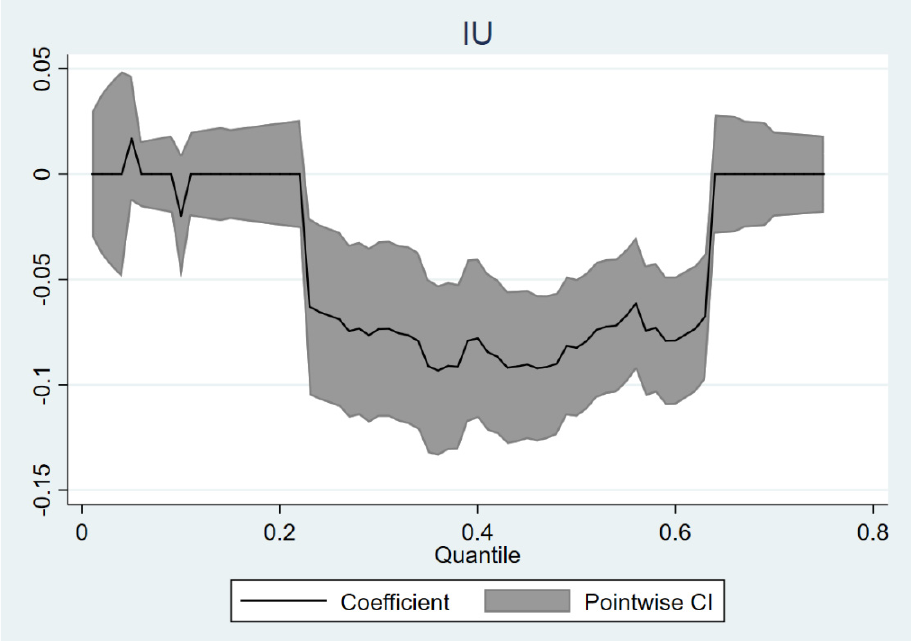
Figure 1. Quantile regression coefficient plot of IU. Table 4. Sensitivity